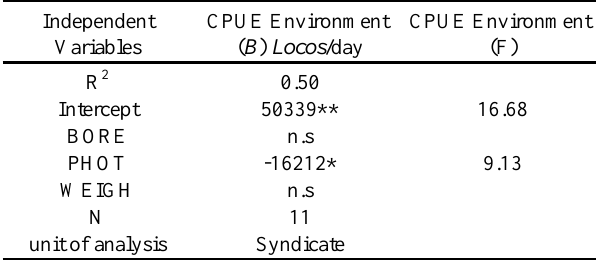
Table 3 . Regression models of catch-per-unit effort (CPUE) for environmental models. The environmental model included loco shell-boring organisms, chlorophyll-a concentration in the management area, and loco weight.